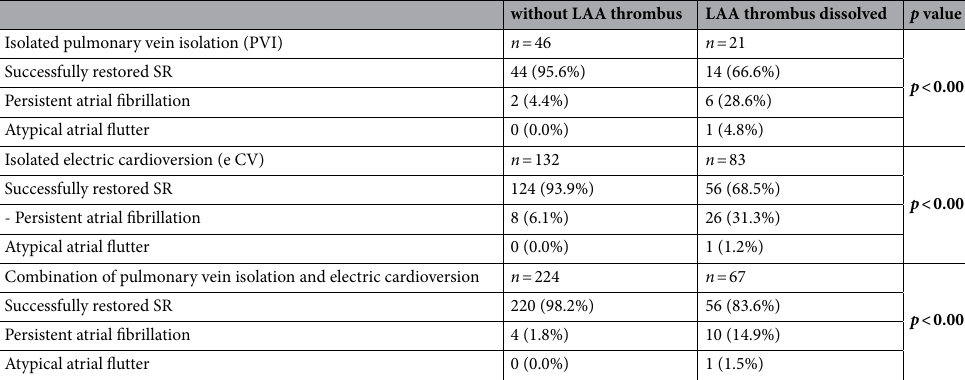
without LAA thrombus LAA thrombus dissolved p value